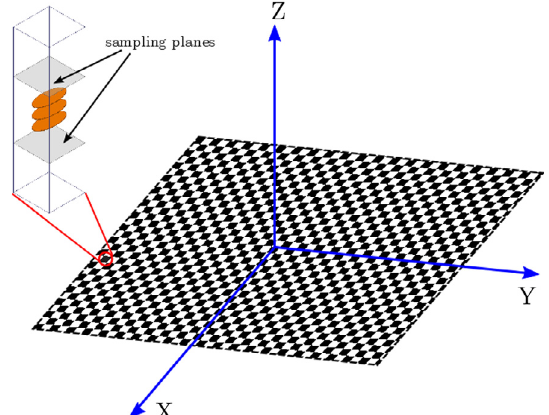
Figure 11. Surface currents J S and M S are computed from the sampled E-field and H-field on the sampling planes that reside in the near field of the radiating patches. By stitching together the surface currents from all the unit cells in the array, the far-field pattern can be